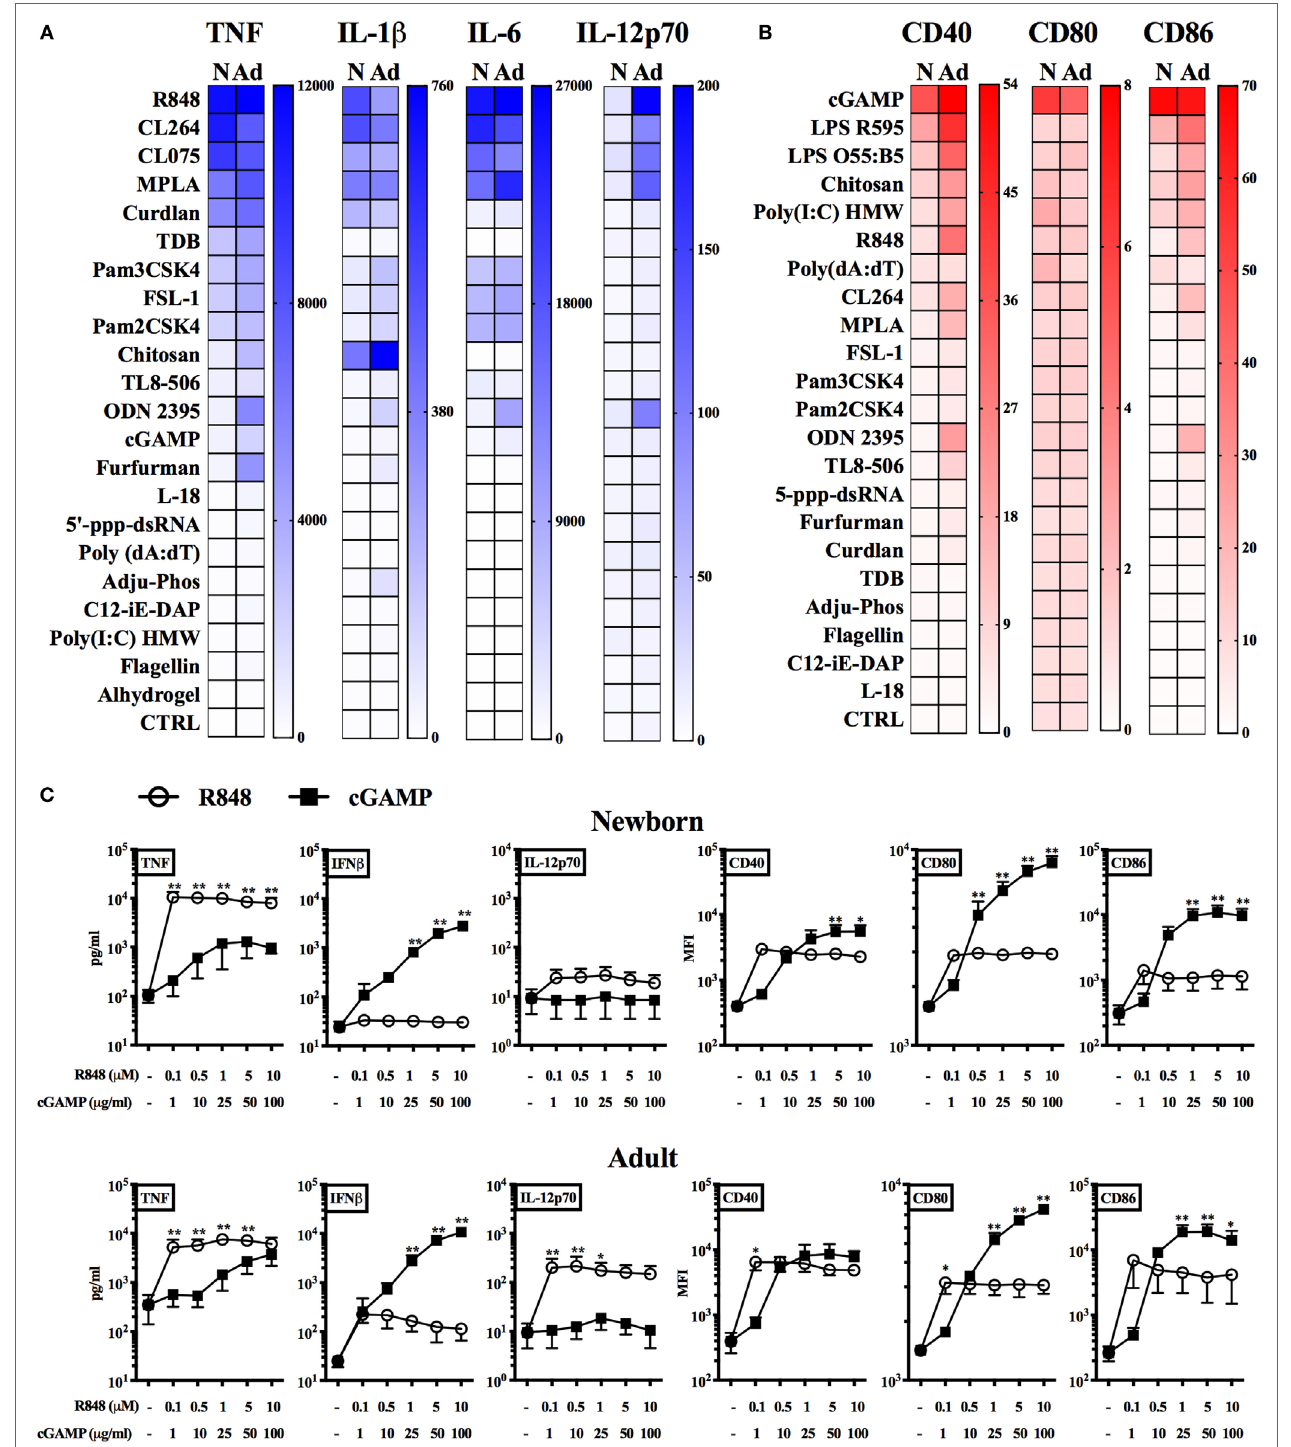
FigUre 1 | Screening of pattern recognition receptor (PRR) agonists on neonatal and adult BMDCs. (a–c) Newborn (N) and adult (Ad) BMDCs were stimulated with the indicated PRR agonists or adjuvants for 20–24 h. Cytokine production (a,c) and MFI of surface marker expression (B,c) were, respectively, assessed by ELISA and flow cytometry. (a,B) Color intensities of the heatmaps are proportional to (a) mean cytokine levels (expressed as pg/ml) or (B) mean co-stimulatory molecule levels (expressed as fold change of median fluorescence intensity over CTRL) of 5–6 (a) or 3 (B) independent experiment. (c) Results are expressed as mean + SEM of 4–5 (cytokine production) or 3 (surface marker expression) independent experiments. * p < 0.05, ** p < 0.01 determined by repeated measures two-way ANOVA with Sidak post hoc